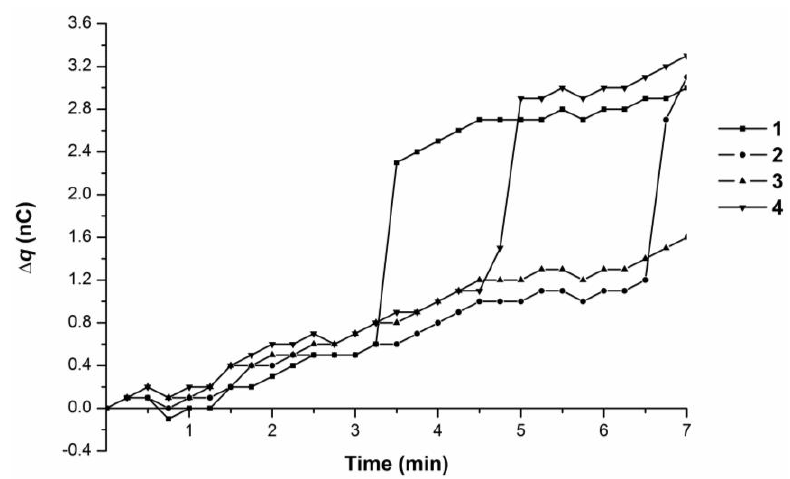
Figure 6. Time dependence curves of charge accumulation ∆q(t) upon 10 −15 M BSA solution influx from the tip in the flow-through system at 38 °C. Curves 1–4 represent parallel measurements of the same experimental series.